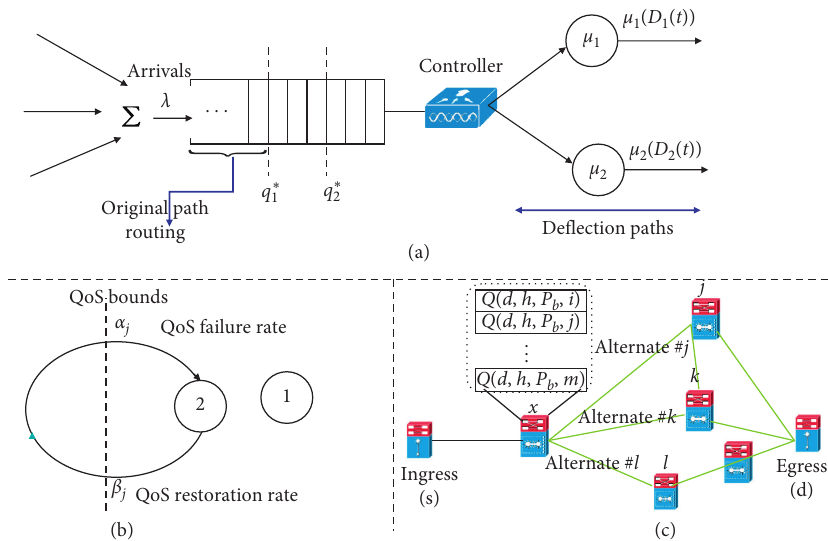
Figure 5: (a) Proposed scheme queuing model. (b) QoS state transitions. (c) Routing